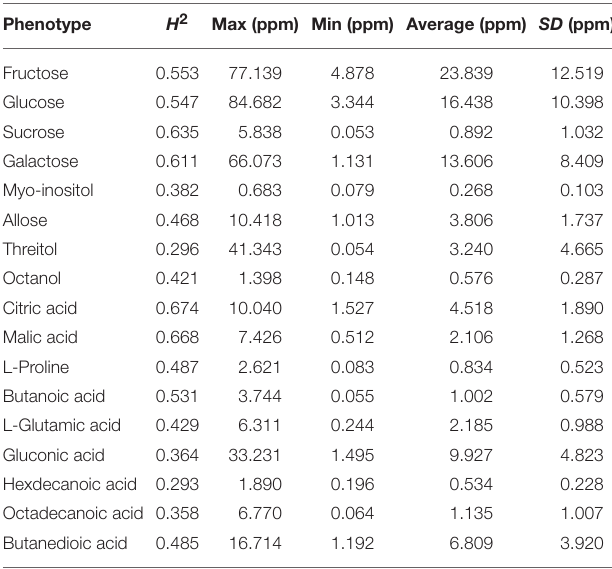
TABLE 1 | Phenotypic variation of main tomato fruit sugars and organic acids among the 174 tomato accessions.